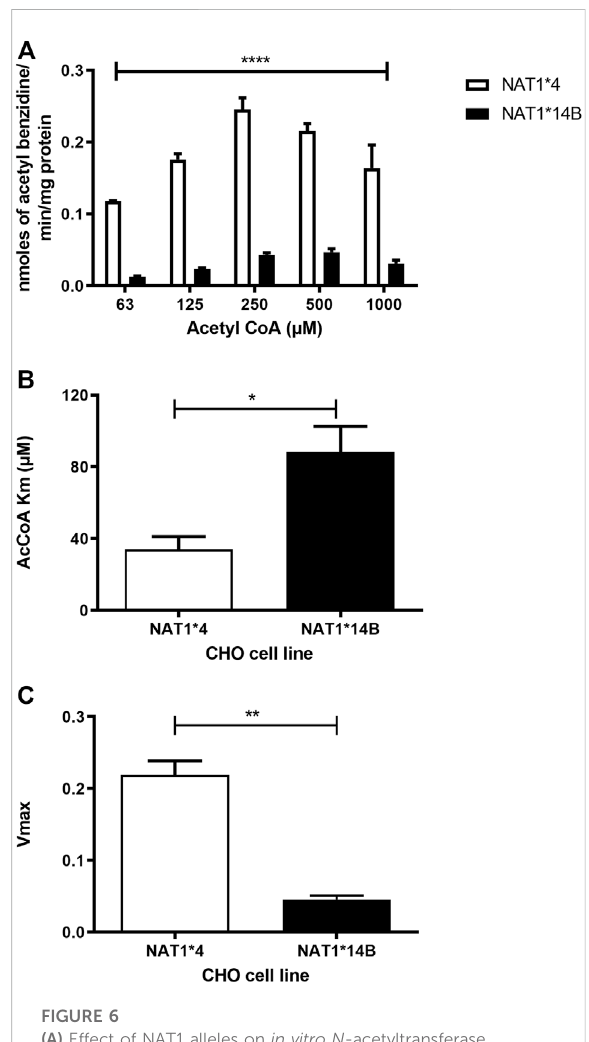
FIGURE 5 (A) Effect of NAT1 alleles on in vitro N -acetyltransferase catalytic activities towards BNA using AcCoA (62.5 – 1,000 µM). (B) Apparent AcCoA K m is higher in NAT1*14B compared to NAT1*4 (1.5- fold). (C) V max (nmol/min/mg) was signi fi cantly higher in NAT1*4 compared to NAT1*14B . Data represents Mean ± S.E.M. of three separate experiments (*** p < 0.001, **** p < 0.0001).